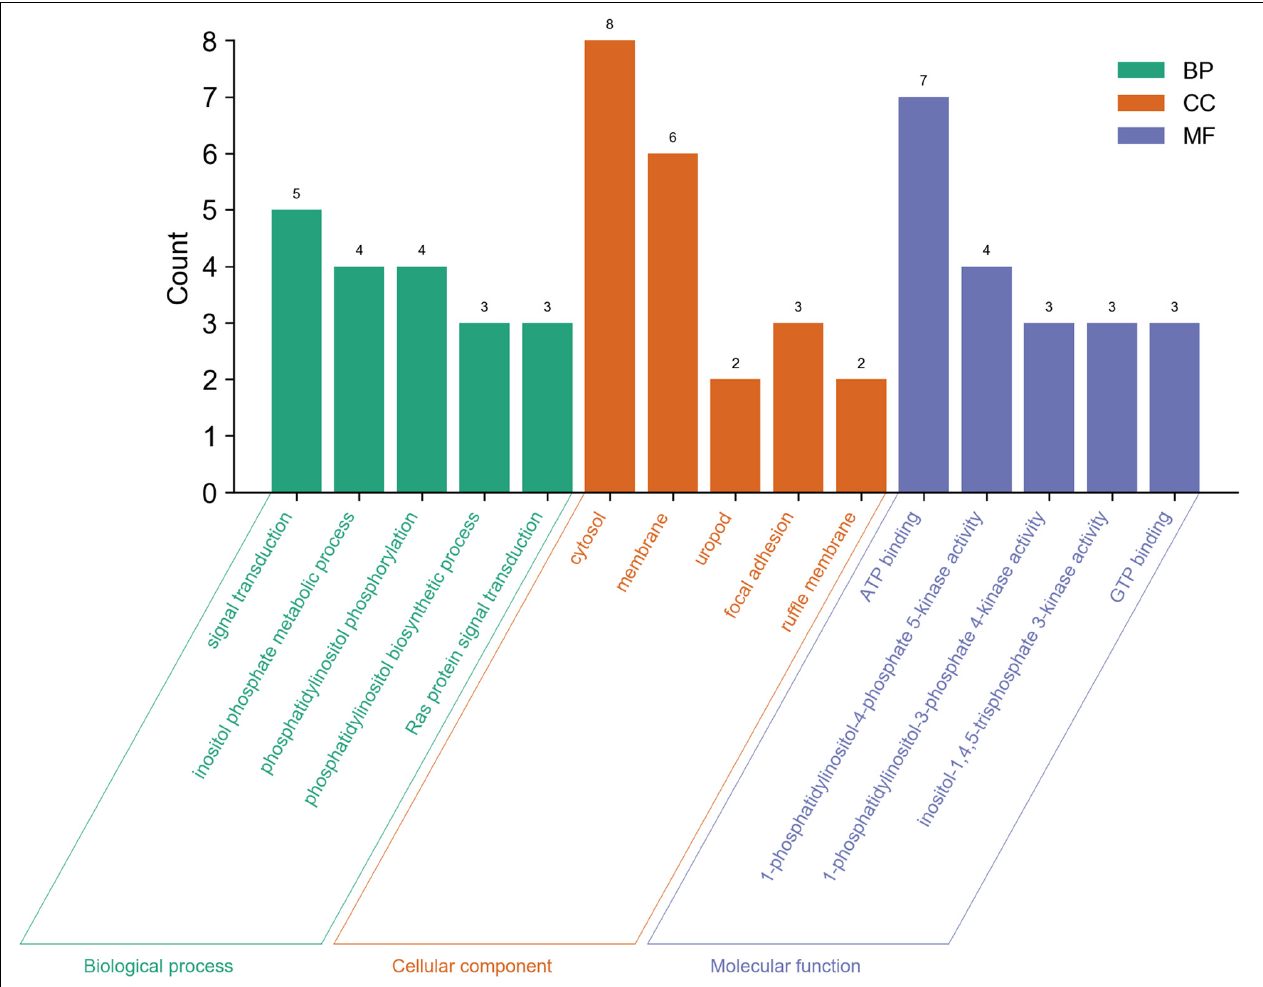
FIGURE 3 | The GO enrichment analysis of PLCE1 and its co-expression genes by DAVID database. BP (biological process) was marked in green; CC (cellular component) was in orange; and MF (molecular function) was in purple.